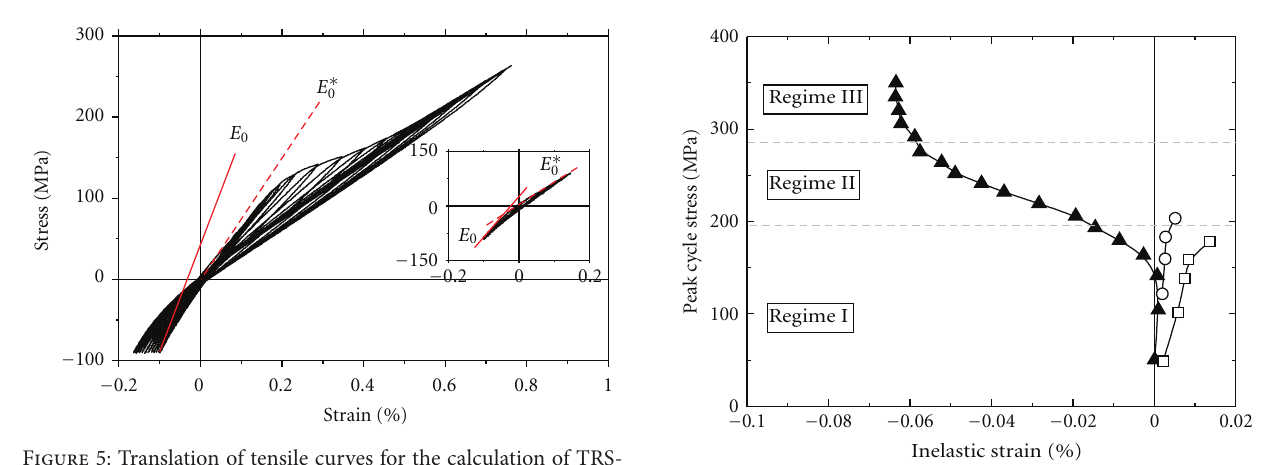
F 5: Translation of tensile curves for the calculation of TRS- free origin and associated properties such as elastic modulus.